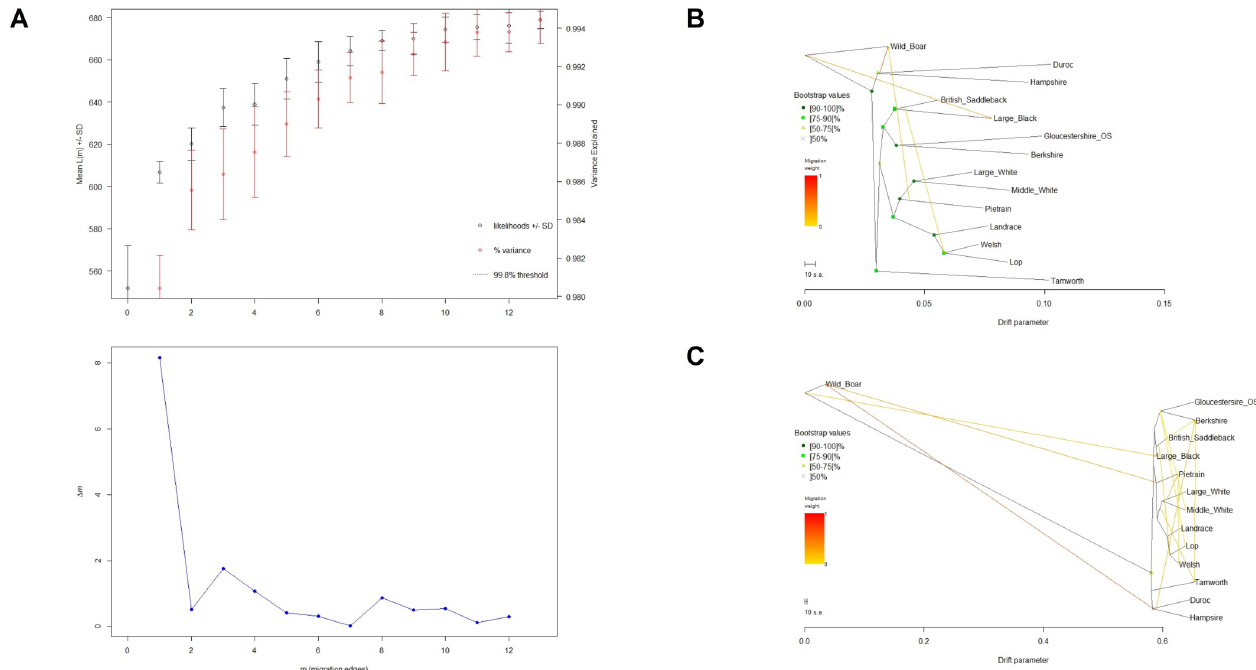
Fig 4. Evanno analyses (A) and maximum-likelihood consensus trees with 4 (B) and 12 (C) migration edges for 14 pig populations. For a total of 405 samples and 14,628 SNPs, allelic frequencies per breed were estimated in PLINK, using Treemix to create the trees. The Evanno method (10 bootstrap replicates per node number) was used to estimate the optimal number of migration nodes; 12 migration edges explained 99.4% of the variance, while 4 migration edges explained 98.6% of the variance.